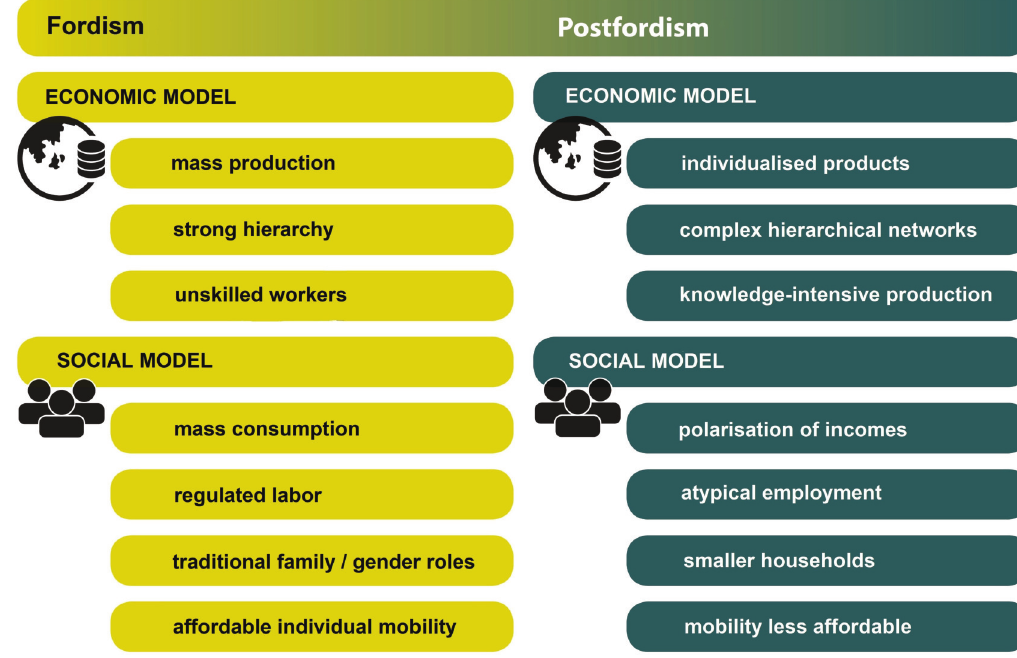
Figure 1. Comparison of the economic and social model of Fordism and post‐Fordism. market, women became particularly active in the social, health, and education sectors (Häußermann & Siebel, 1995, p. 186). Parallel to this, family and household forms also changed and the classic nuclear family lost importance—and with it, ultimately, the suburban way of